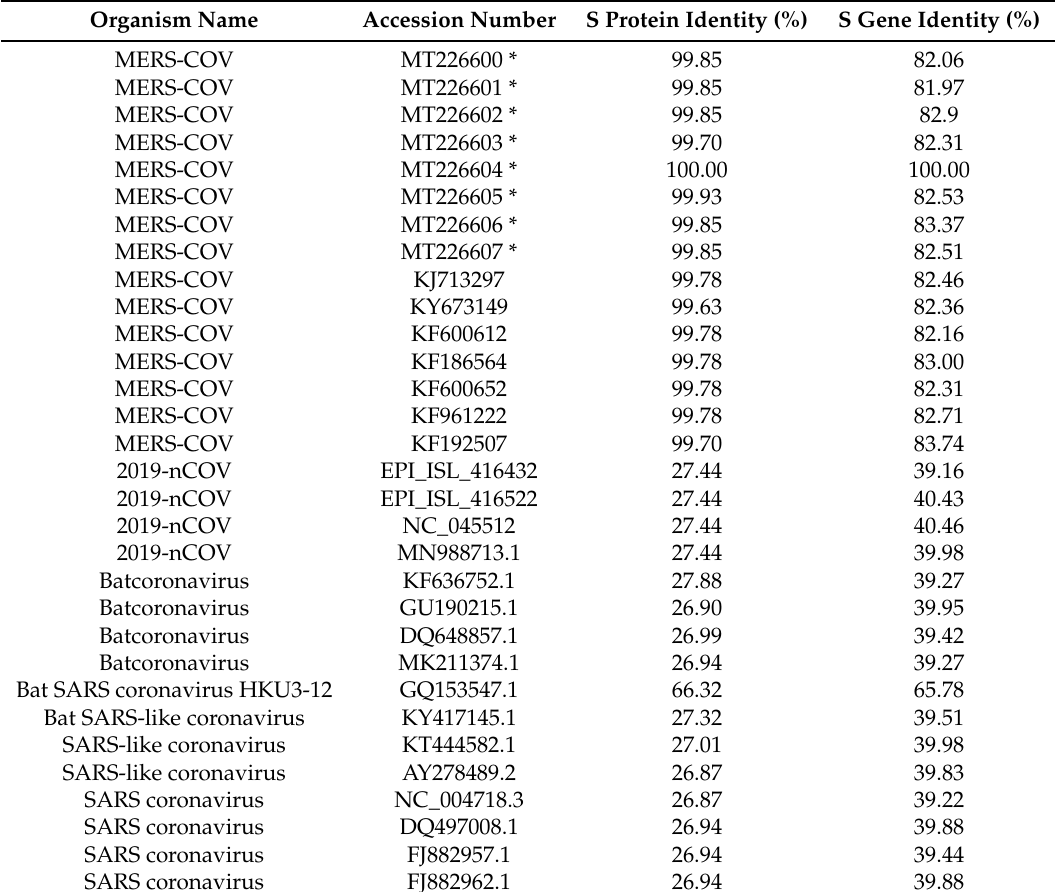
Table 1. List of viruses from genus Betacoronavirus used in this study showing their S protein and S gene homologous